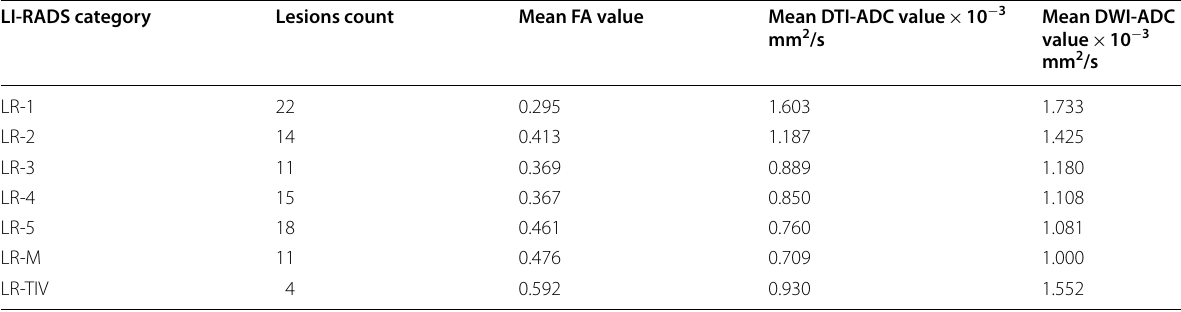
Table 3 Descriptive analysis of the FA, DTI-ADC and DWI-ADC values according to the LI-RADS categories LI-RADS category